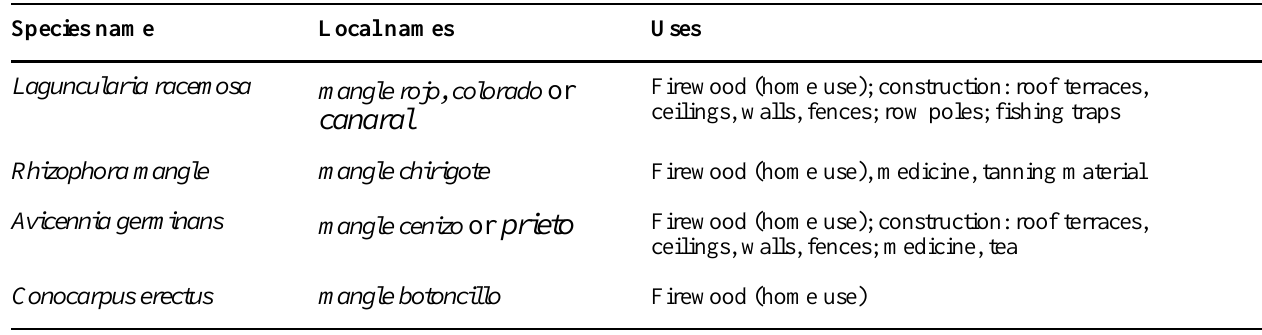
Table 1. Traditional uses of mangrove by local people from the Navachiste-San Ignacio-Macapule lagoon